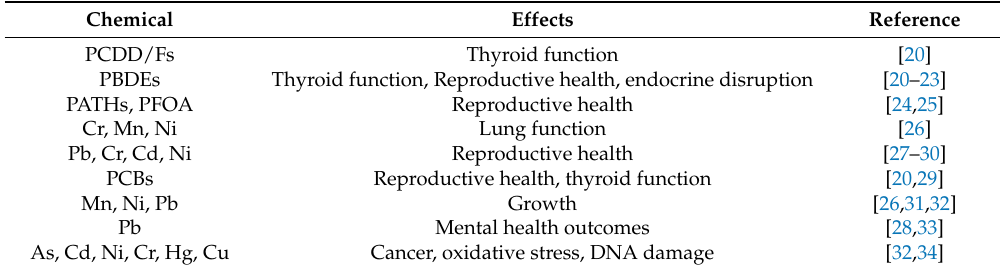
Table 1. Evidence of health effects due to long-term exposure to persistent organic